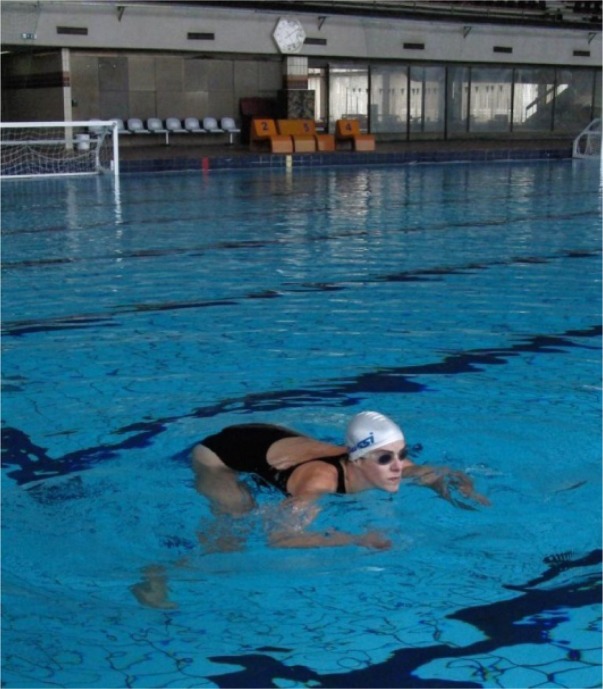
Boost performanceFigure 2a. Start positionFigure 2b. Finish position